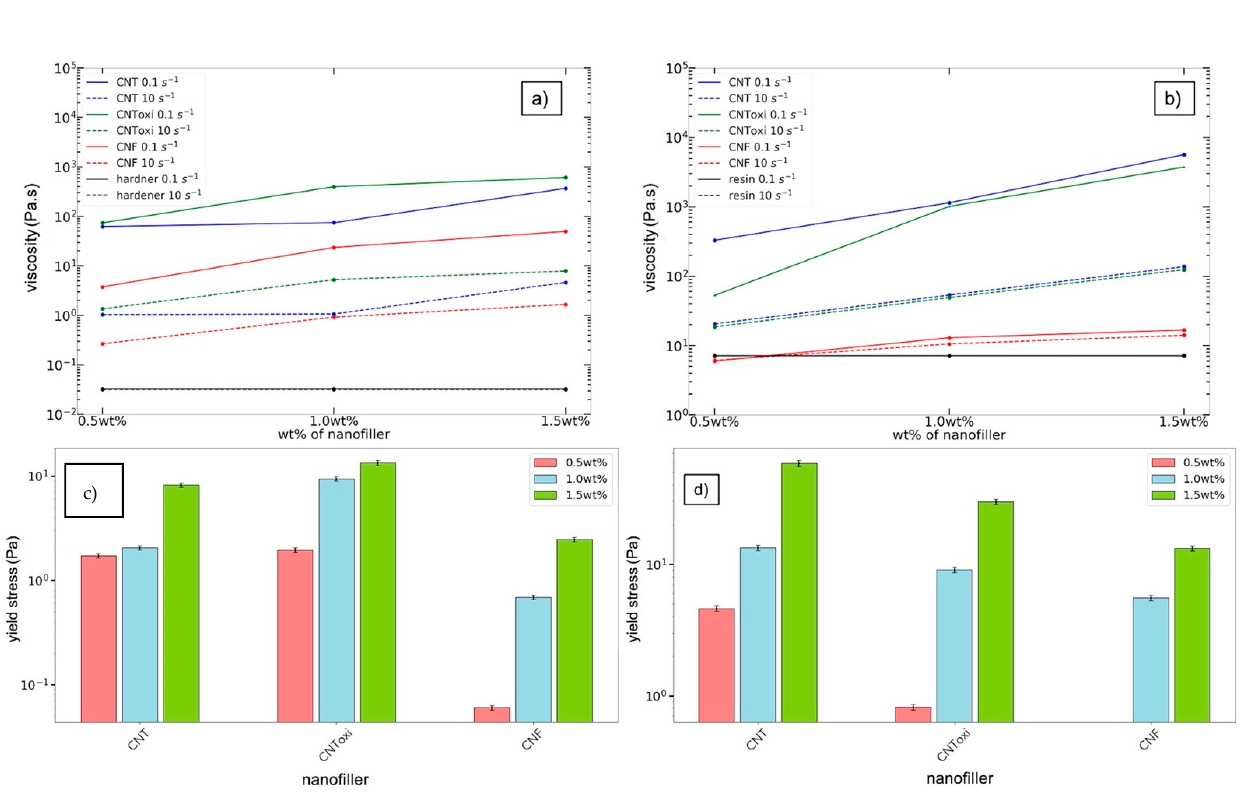
Figure 10. Viscosity values for all nanofillers and filler grades at different shear rate values showing the shear-thinning behavior. a ) US dispersions; b ) TRM dispersion. Yield stress evaluated through rotational shear rate-controlled tests c ) US dispersion; d ) TRM dispersion. Errors for the viscosity values and the yield stress are estimated to be 5% due to the evaluation process.